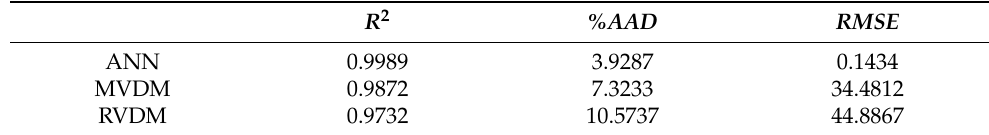
Table 6. Using experimental data to compare the accuracy of the models. R 2